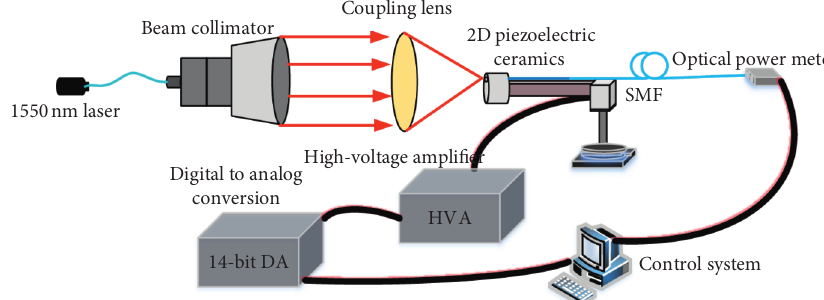
Figure 4: Schematic diagram of the spatial light-fiber coupling automatic alignment